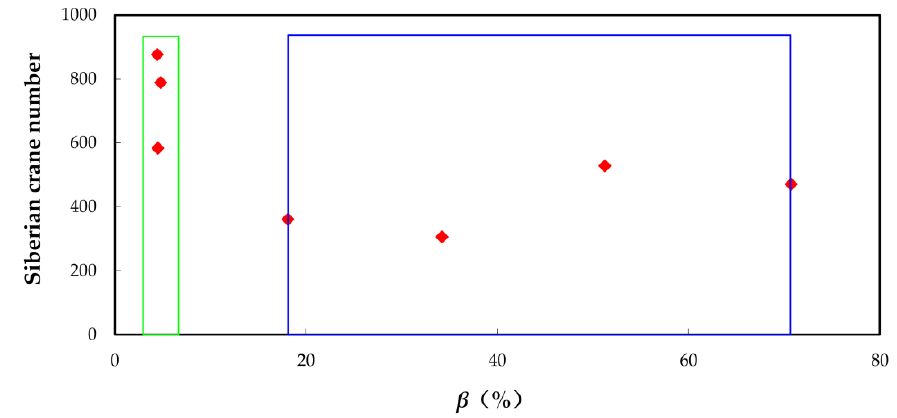
Figure 5. Relationship between Siberian crane number and β value.